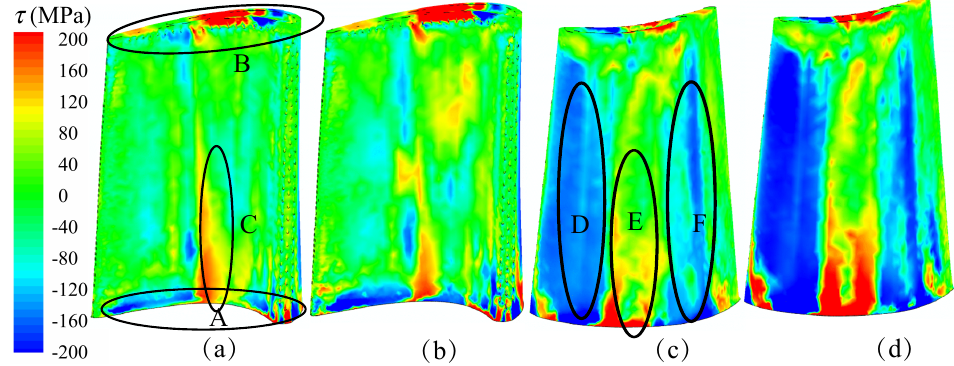
Figure 11. MRSS distribution of the rotor blade: ( a ) pressure side and ( c ) suction side under the rotating condition; ( b ) pressure side and ( d ) suction side under the stationary condition (A–F indicate the local high MRSS areas).